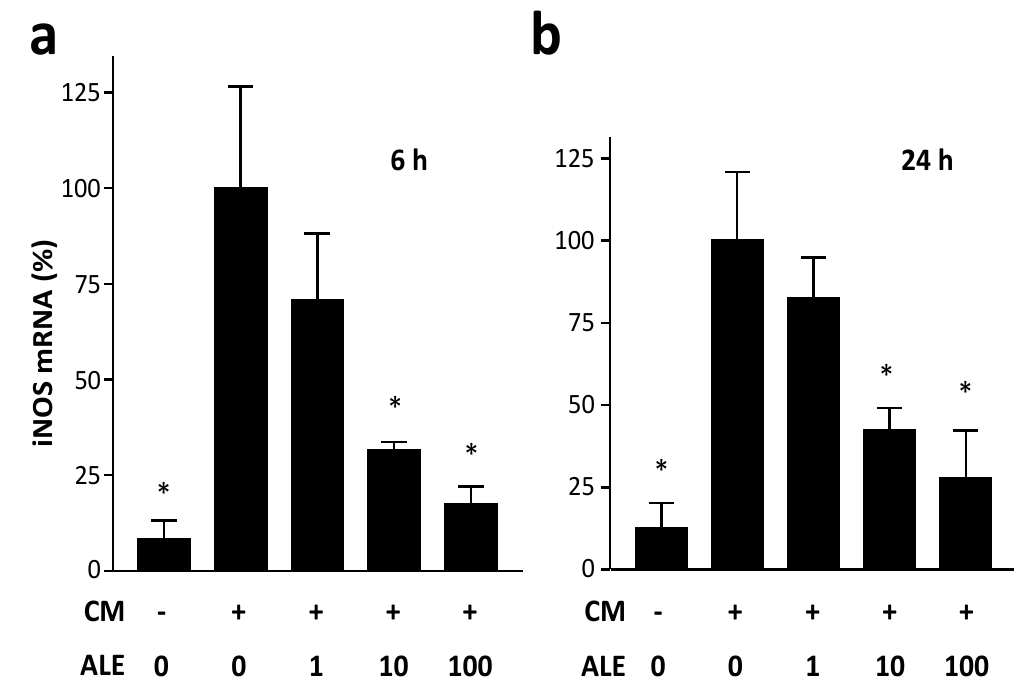
Figure 1. Artichoke leaf extracts downregulate iNOS mRNA expression. Human coronary artery smooth muscle cells were treated with the cytokine mixture (CM) or CM in combination with the artichoke leaf extract (ALE, µg/mL) for 6 h ( a ) or 24 h ( b ). Human iNOS mRNA expression was analyzed with real-time RT-PCR. * p < 0.05, compared with CM.